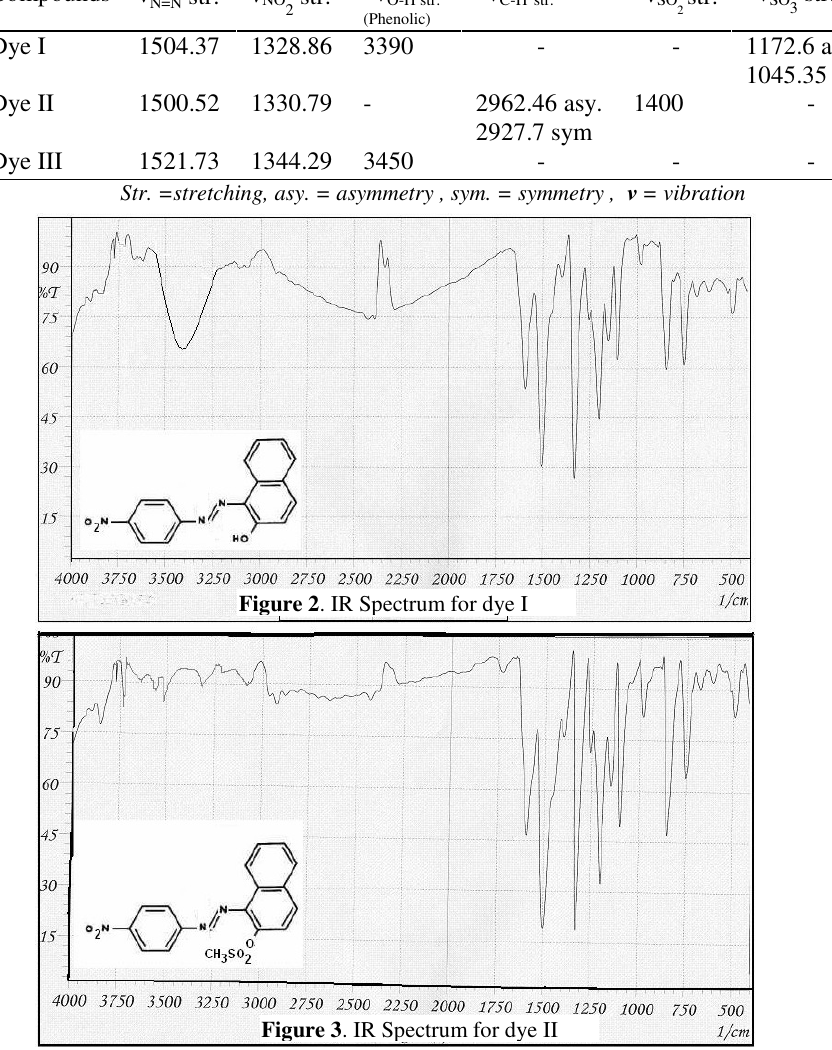
Figure 3 . IR Spectrum for dye